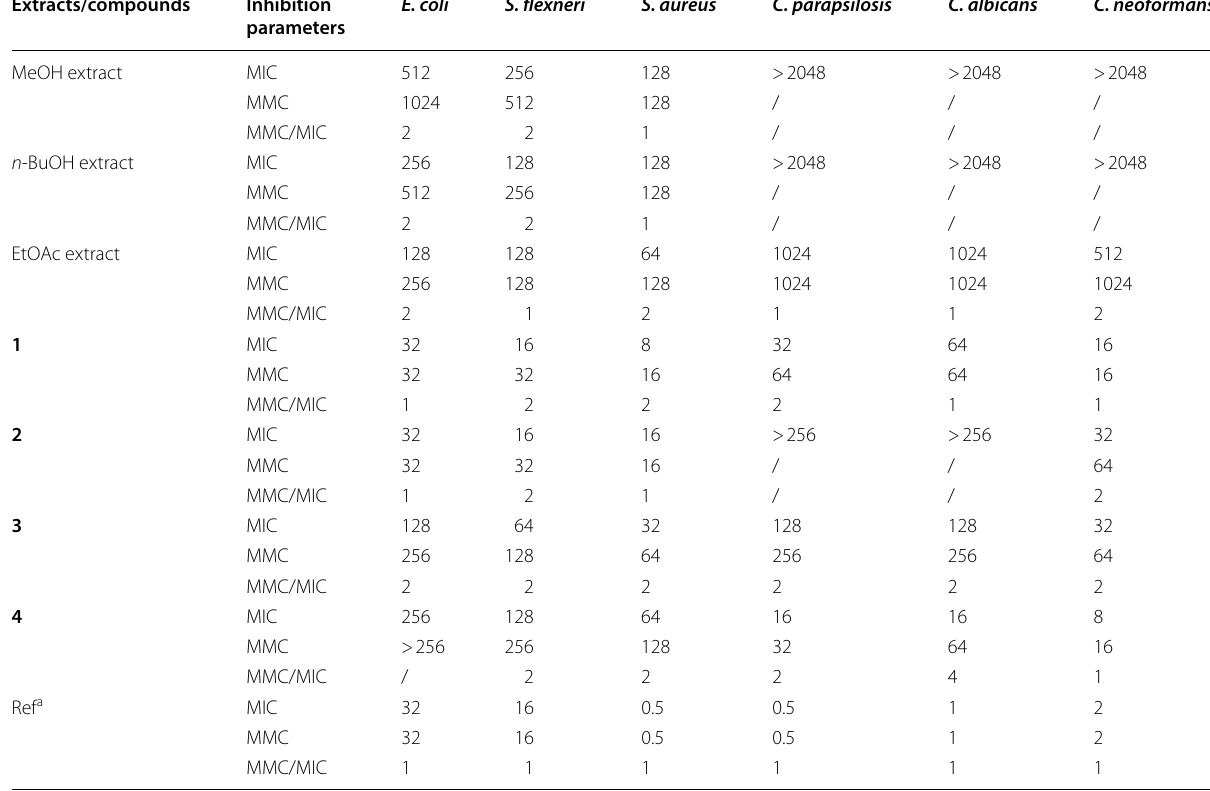
Table 1 Antimicrobial activity (MIC and MMC in µg/mL) of extracts, isolated compounds and reference antimicrobial